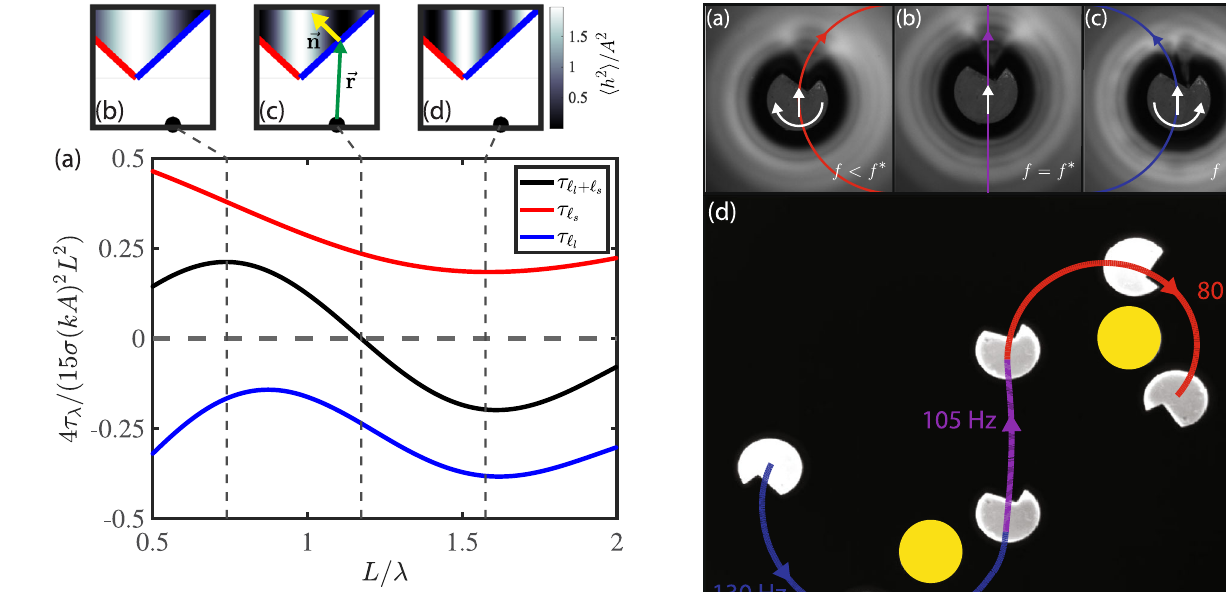
Fig. 4 Theoretical dimensionless torque as a function of the dimensionless spinner size ( L / λ ). a The black curve represents the sum of the contributions from the short arm (red curve) and long arm (blue curve). For smaller sizes of spinner or low vibrational frequency, the net torque is positive and exhibits a local maximum before eventually fl ipping sign as the size of the spinner or driving frequency is increased. The time-average square wave fi elds in the wedge as predicted by the crossed-wave model (2) are shown in b , c , and d for three representative cases along with the normal vector to the wedge ( n , yellow) and the radial vector from the center of the spinner ( r , green). The black dot in the lower corner of each box denotes the geometric center of the spinner.